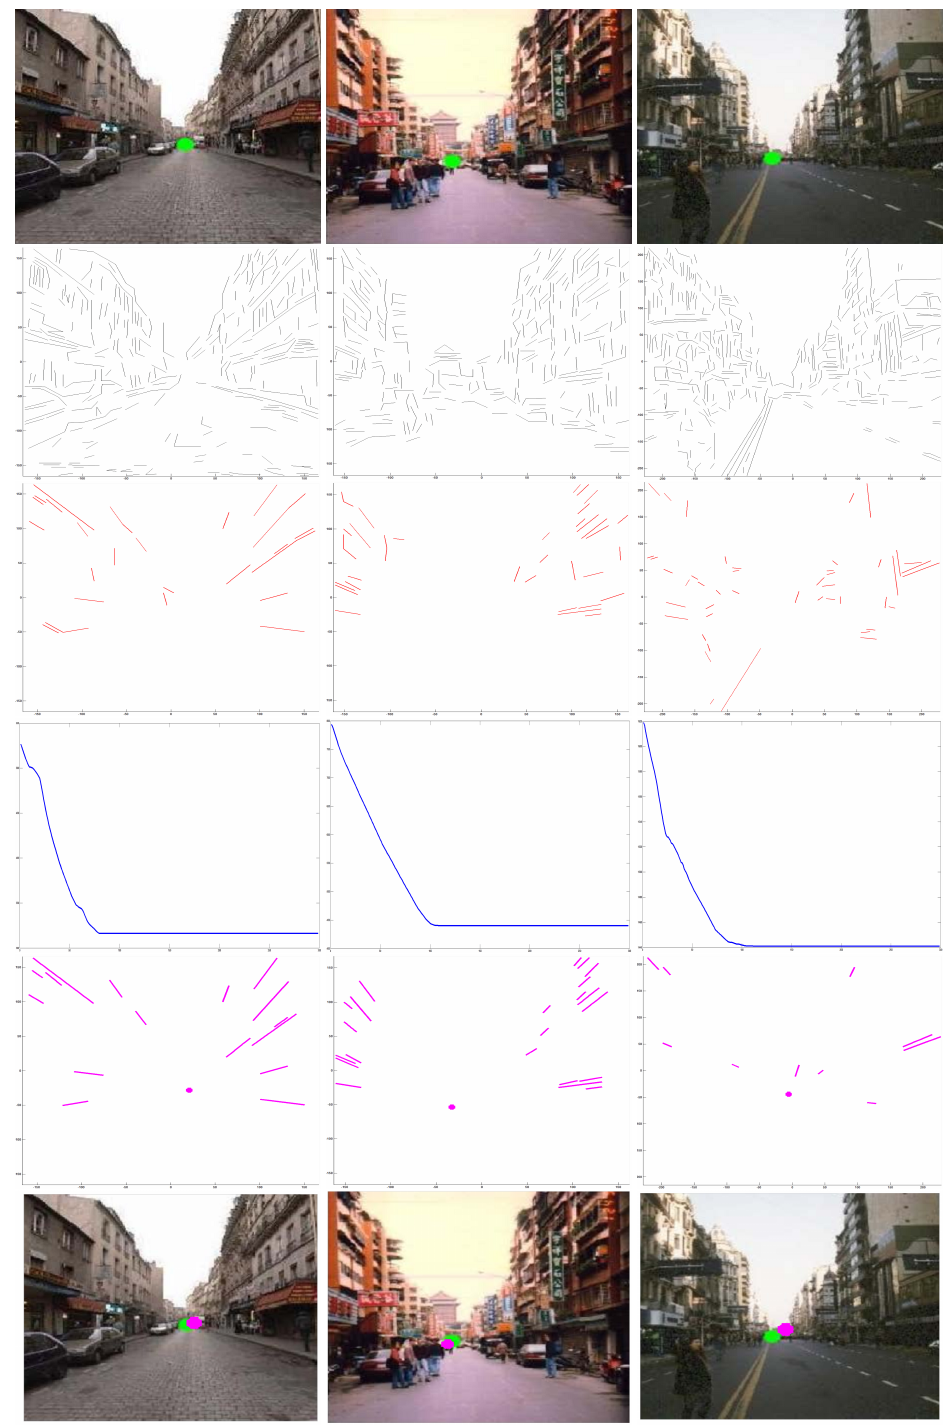
Figure 5. Experimental comparison. First row : input capture [14]. Second row : original lines. Third row : refined lines. Fourth row : convergence. Fifth row : optimal estimation. Bottom row : the green point is estimated by Hyeong’s method [14], and the pink point is the estimated VP by our method. Our algorithm has better estimation based on refined